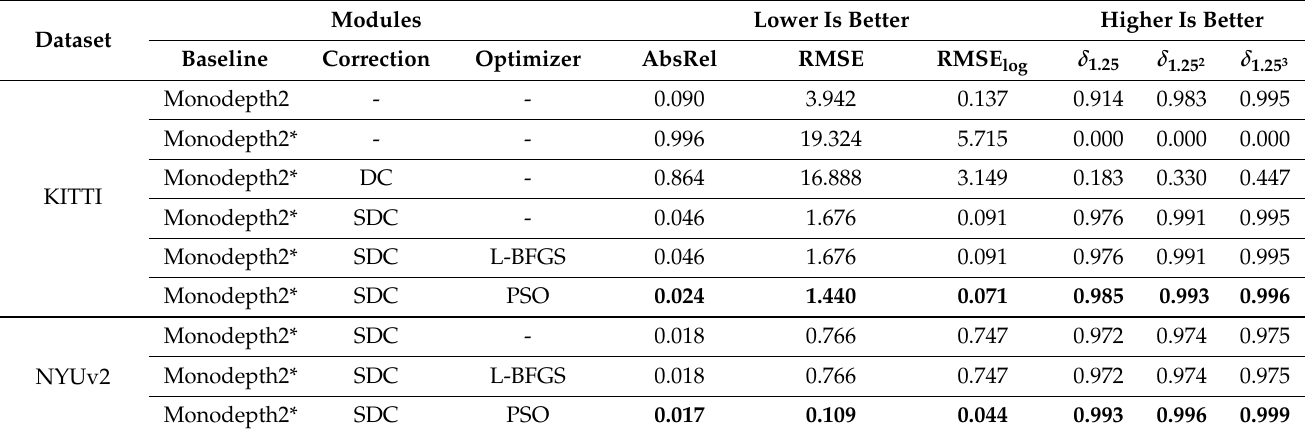
Table 1. Ablation study on KITTI and NYUv2. Monodepth2* is the version of Monodepth2 without median